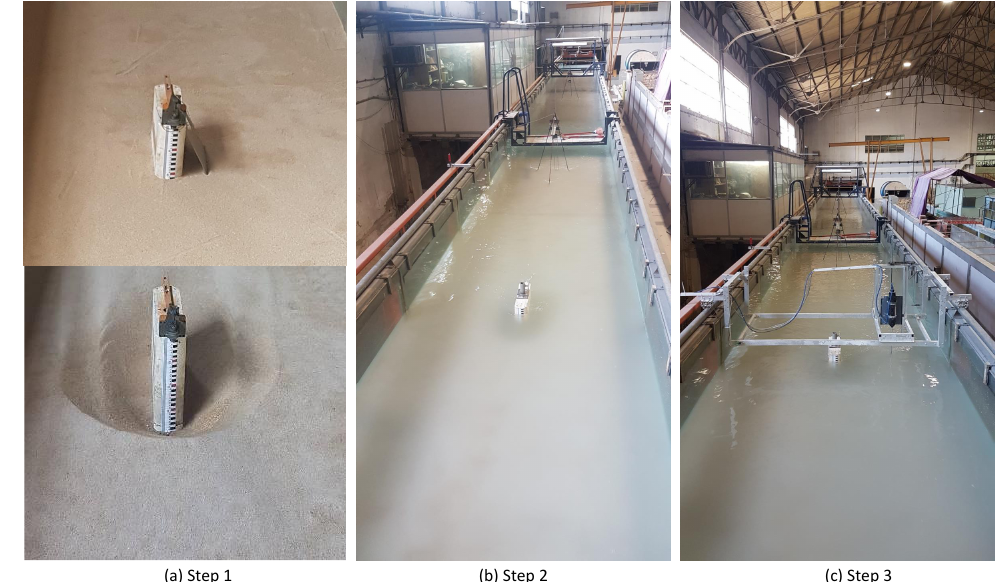
Figure 4. Setup for the flow velocity